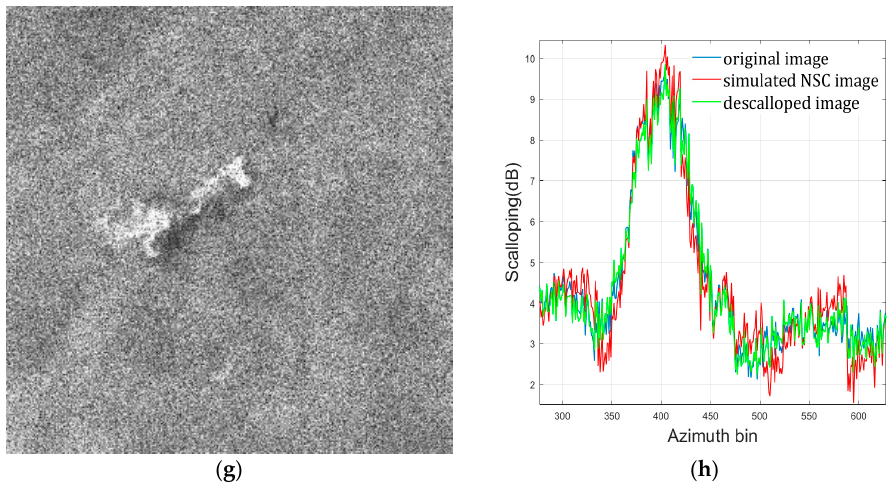
Figure 12. Results of simulated ScanSAR image: ( a ) stationary sea surface in the standard strip (SS) image; ( b ) stationary sea surface in the simulated ScanSAR image; ( c ) stationary sea surface in the descalloped ScanSAR image; ( d ) scalloping comparation of ( a–c ); ( e ) non-stationary sea surface in the SS image; ( f ) non-stationary sea surface in the simulated ScanSAR image; ( g ) non-stationary sea surface in the descalloped ScanSAR image; ( h ) scalloping comparation of ( e–g ).